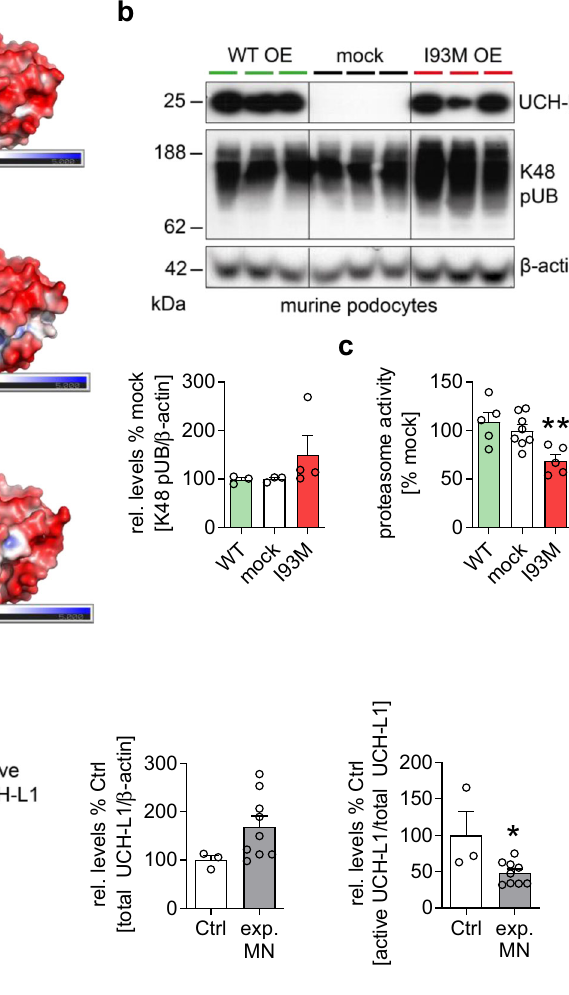
Fig.2|UCH-L1ismodi fi edinexperimentalMN.a Calculatedelectrostaticsurface potentialofthecrystalstructuresofUCH-L1wildtype(PDB:2ETL,UCH-L1 WT